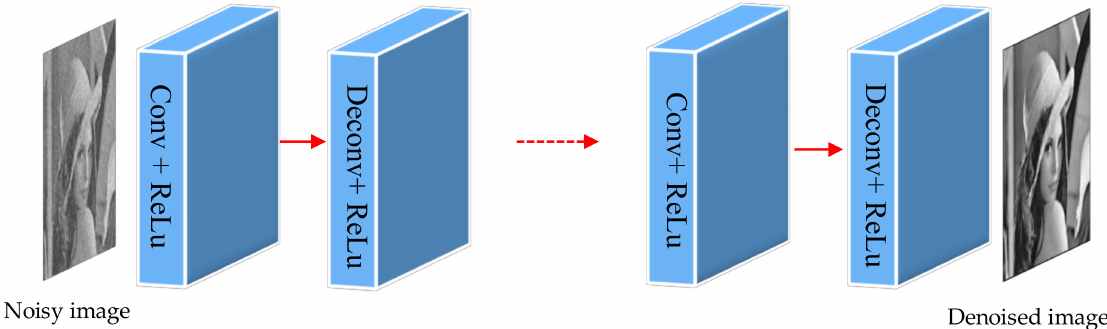
Figure 1. The architecture of the proposed